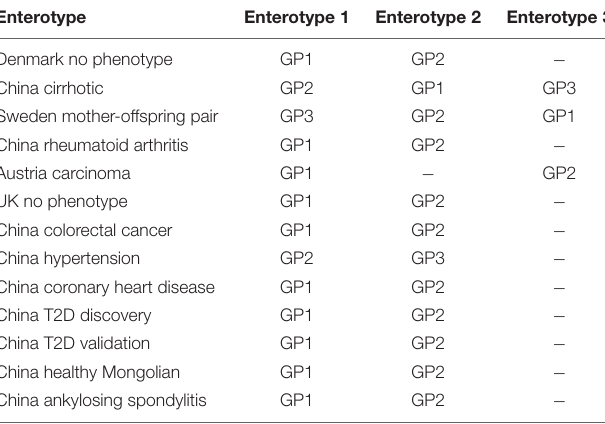
TABLE 2 | Manually categorized results for each